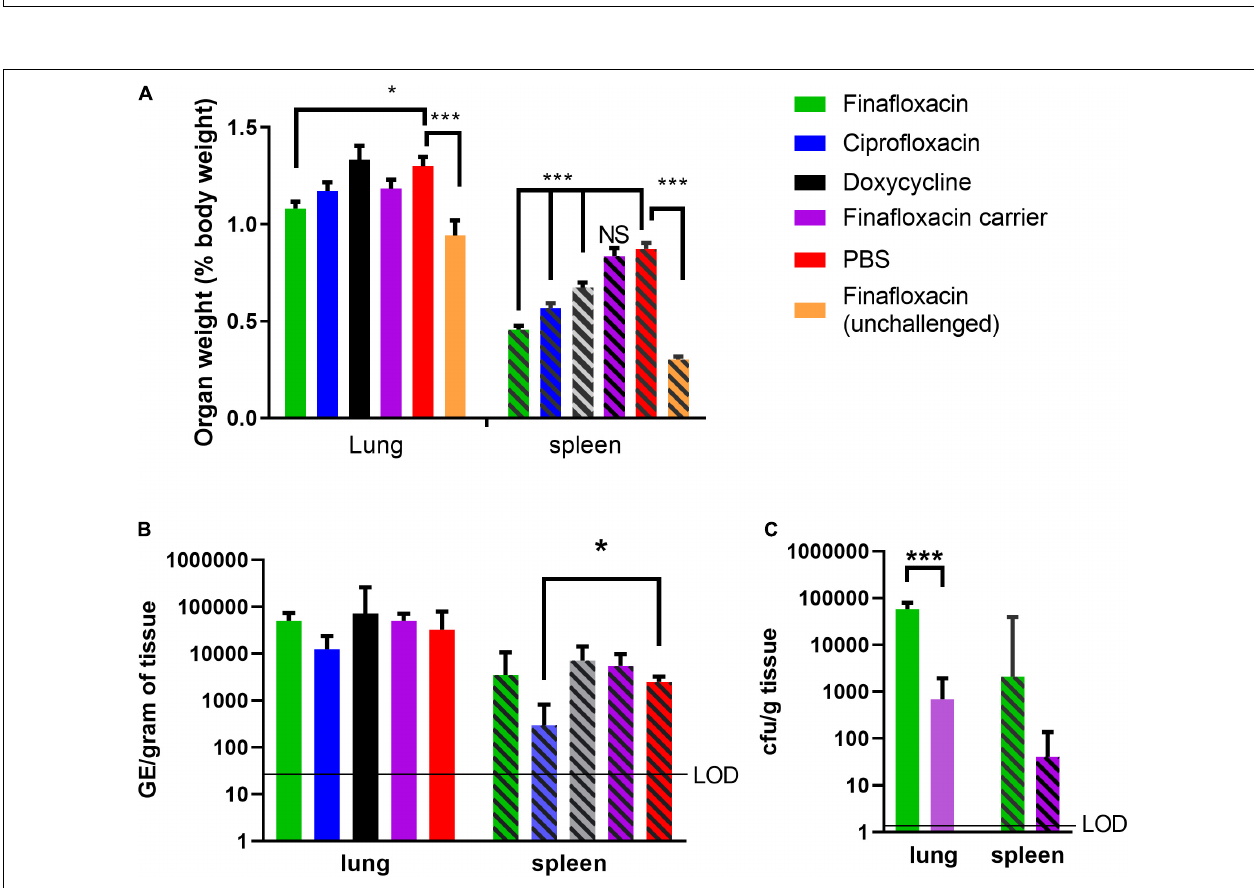
FIGURE 2 | Organ weight and bacterial load at day 14 post-challenge in mice challenged with C. burnetii and treated with antibiotics. At 24 h post-challenge mice were treated with finafloxacin (30 mg/kg once a day orally), ciprofloxacin (22 mg/kg every 12 h via intraperitoneal injection) or doxycycline (105 mg/kg once daily orally) for 7 days. Control animals received PBS or the carrier orally. One group of mice received finafloxacin and were unchallenged. (A) Lung and spleen weight as a percentage of total body weight, (B) bacterial load in lungs and spleens assessed by RT PCR, and (C) bacterial load in the lungs and spleens from animals treated with finafloxacin or carrier determined by viable count. Geometric mean and SDs are shown, limit of detection marked LOD. * p < 0.05, *** p < 0.001.